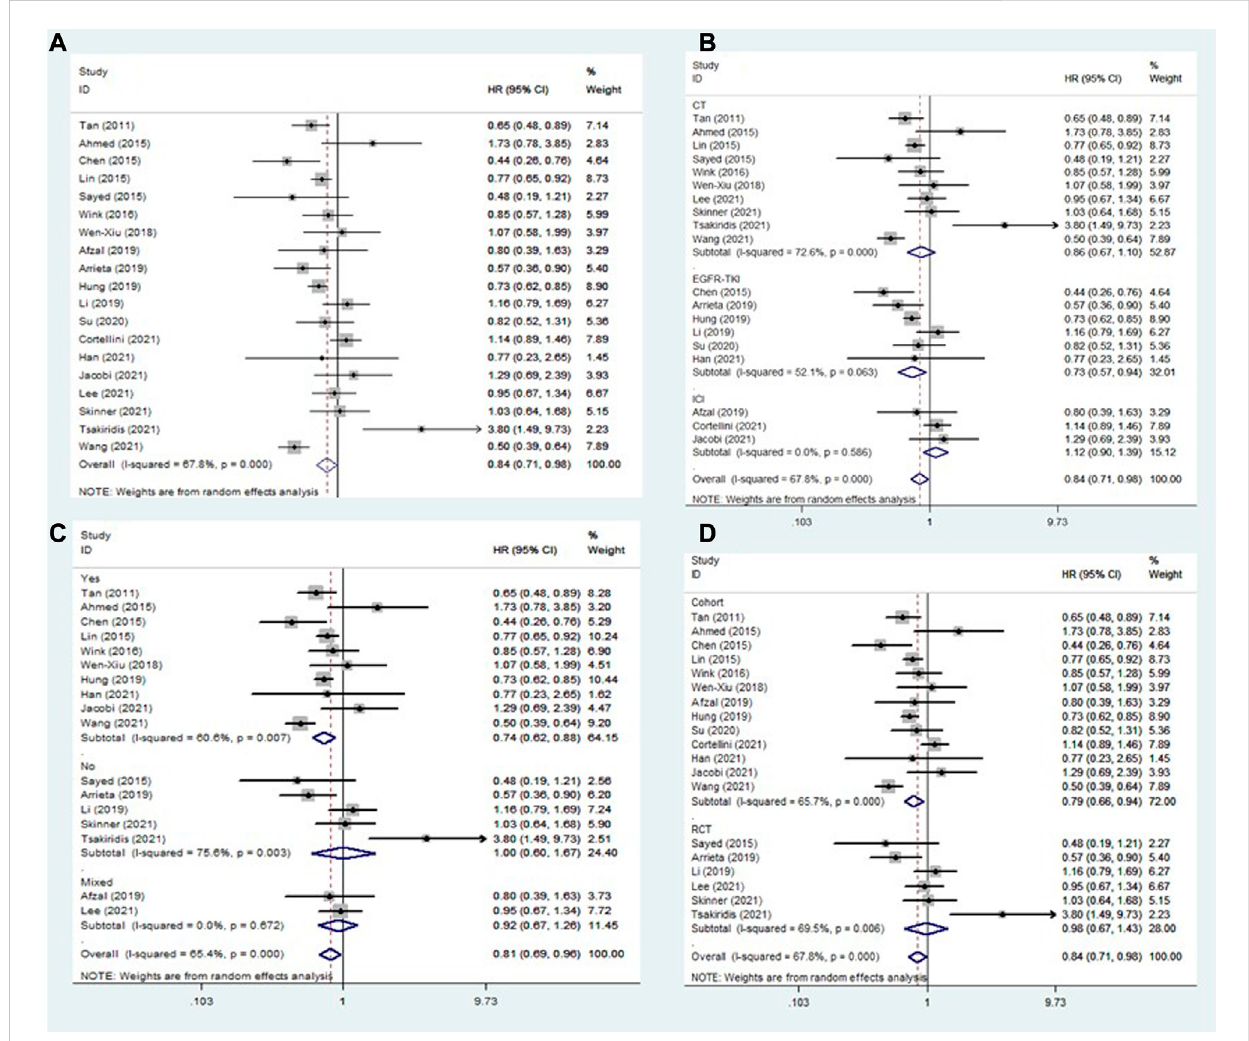
FIGURE 2 The association between metformin use and overall survival in (A) all NSCLC patients; (B) subgroups by treatment type; (C) subgroups by comorbidity of diabetes mellitus; and (D) subgroups by study design. NSCLC: non-small cell lung cancer.